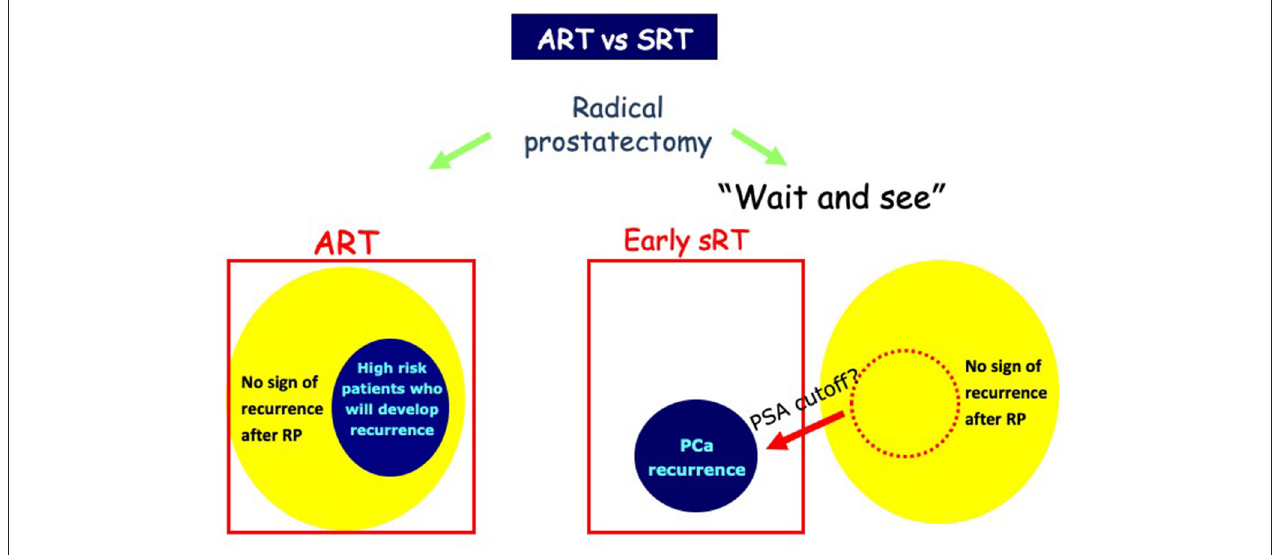
FIGURE 1 | Use of adjuvant RT (ART) and salvage radiotherapy (SRT). Early treatment with ART might be more effective than SRT for biochemical progression. SRT avoids unnecessary treatment of those cured by surgery alone and results in less treatment-related